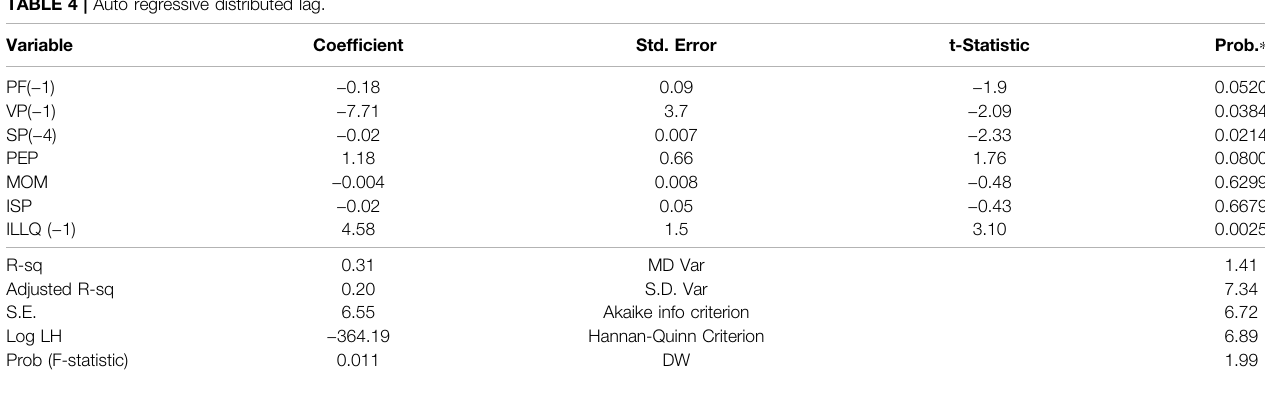
TABLE 4 | Auto regressive distributed